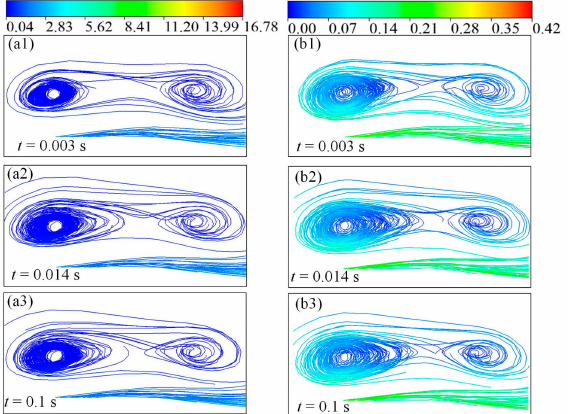
Figure 22. Velocity streamlines of the section inside the hexahedral texture dimple (( a1 ) is velocity streamlines of oil when t = 0.003 s; ( a2 ) is velocity streamlines of oil when t = 0.014 s; ( a3 ) is velocity streamlines of oil when t = 0.1 s; ( b1 ) is velocity streamlines of vapor when t = 0.003 s; ( b2 ) is velocity streamlines of vapor when t = 0.014 s; ( b3 ) is velocity streamlines of vapor when t = 0.1